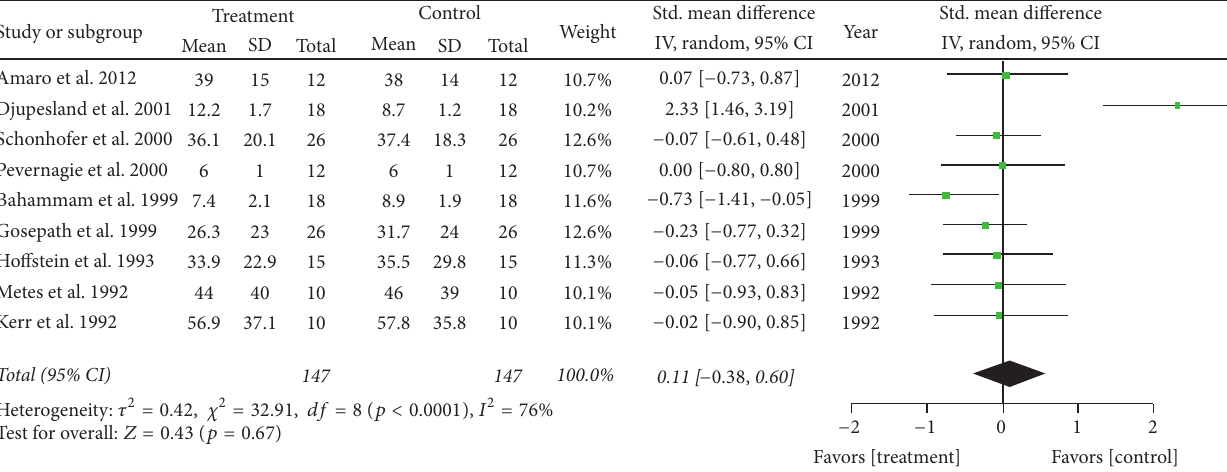
Figure 1: Standardized mean difference for apnea-hypopnea index. The overall standardized mean difference is 0.11 [ −0.38, 0.60 ] corresponding to a small